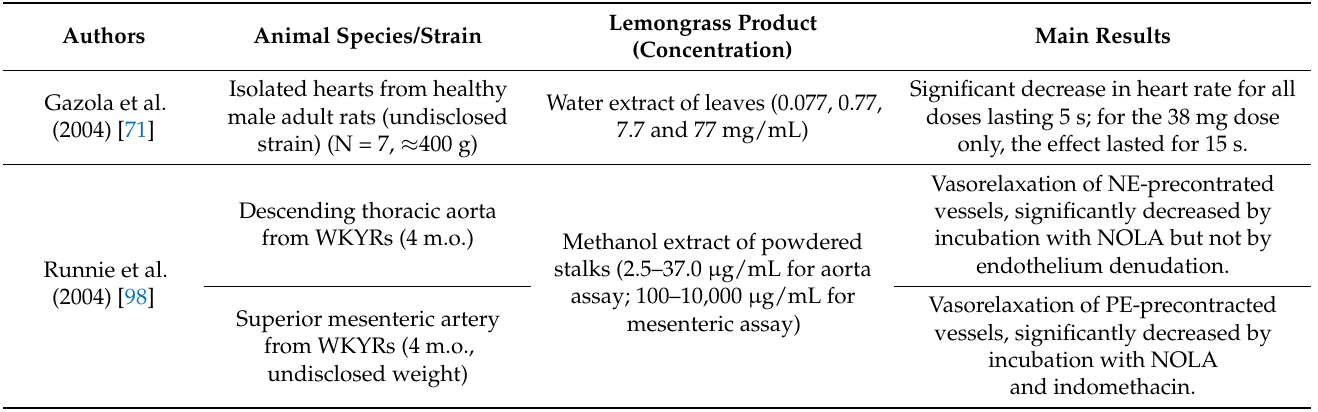
Table 4. Main results of ex vivo studies describing the cardiovascular activities of